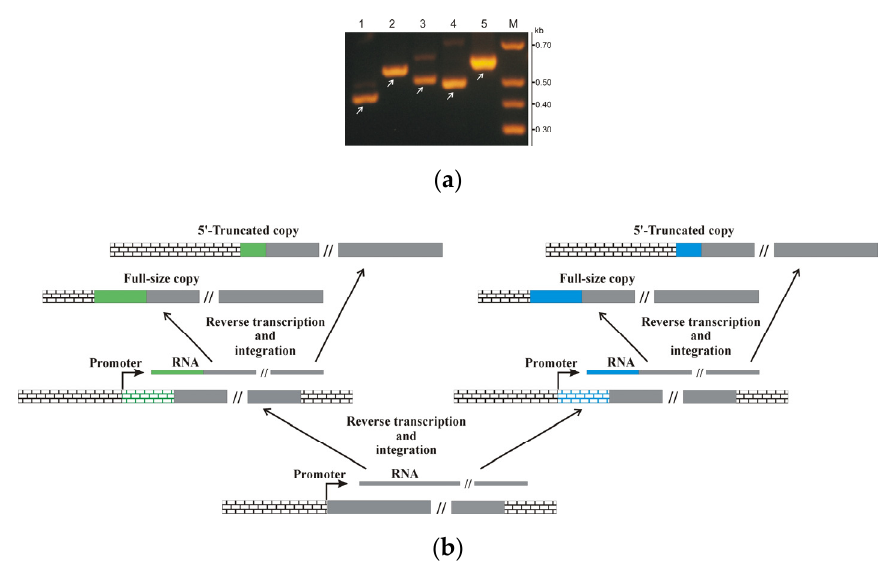
Figure 2. Analysis of the distribution of BLAG retrotransposons of B. germanica in the genome. ( a ) The result of the electrophoretic separation of the amplification products obtained using primers in a 1% agarose gel, one of which is located in the 5 (cid:48) -untranslated region of the BLAG 1 retrotransposon, while the second is located in the genomic environment of 1 –BLAG 1_2, 2 –BLAG 1_3, 3 –BLAG 1_4, 4 –BLAG 1_5, and 5 –BLAG 1_6. Arrows indicate the amplification products used for cloning and sequencing. ( b ) Hypothetical scheme of the transposition of BLAG retrotransposons. cDNA copies of a particular ancestral form of the BLAG retrotransposon (grey) are integrated into two di ff erent sites located next to the promoters of random genes of the host organism. The nucleotide sequences located between the promoter and randomly integrated copies of a particular ancestral form of the BLAG retrotransposon are shown by a line similar to brickwork of varying lengths in green or blue color, depending on the integration site. Solid green and blue lines correspond to newly transcribed retrotransposon variants and their genome-integrated